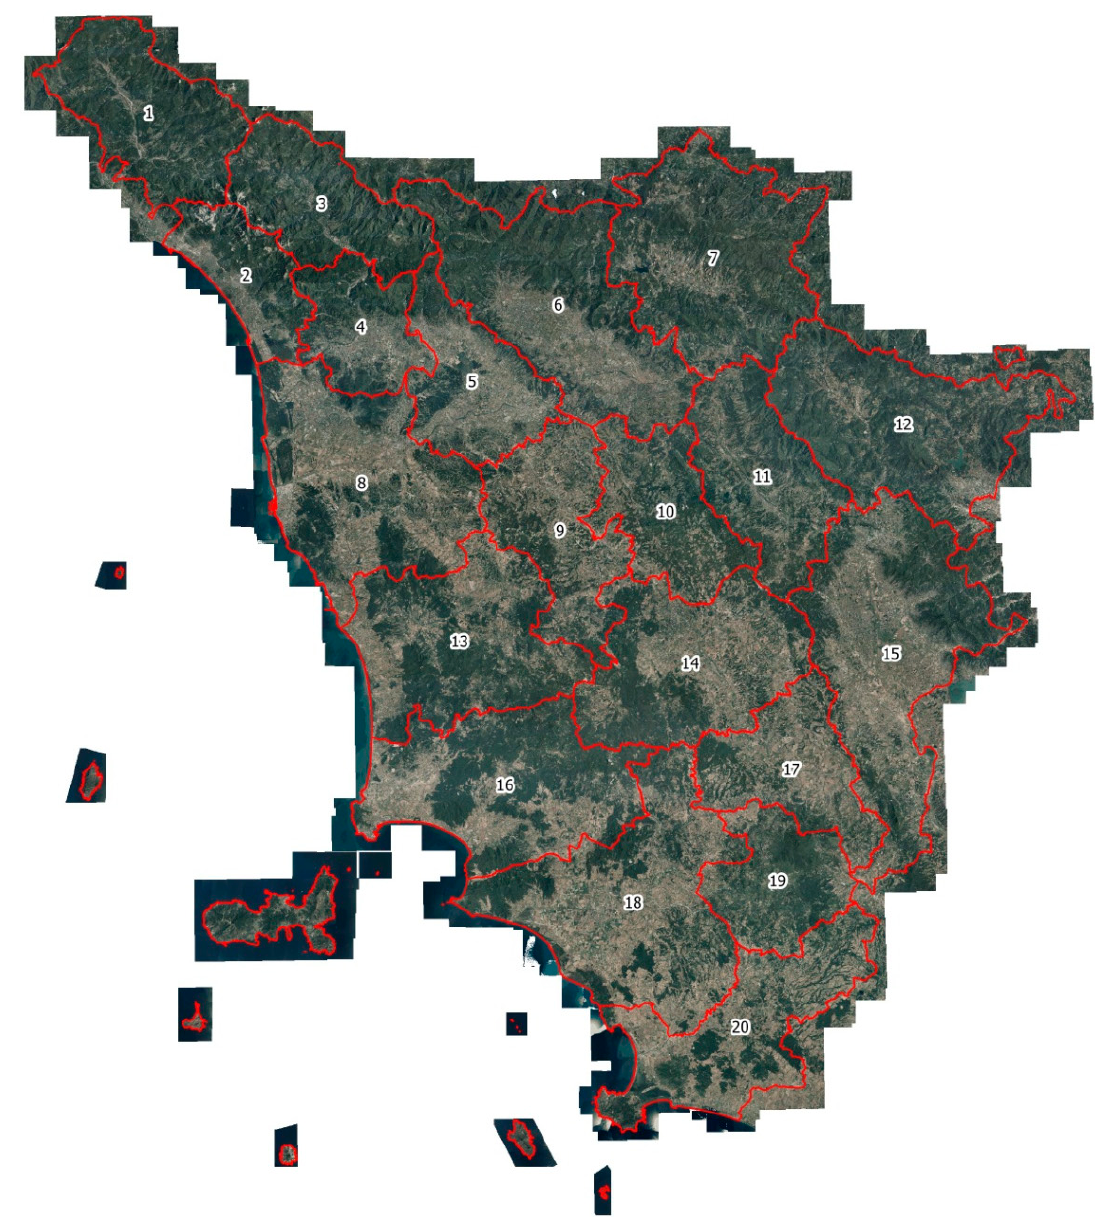
Figure 2. The 20 landscape units in which the territory of Tuscany has been divided according to the landscape plan. In the aerial photo forest areas are in dark green color. As it can be observed they are distributed all over the territory, especially on the Apennine mountains in the north, creating a complex landscape mosaic made of forest and agricultural patches.